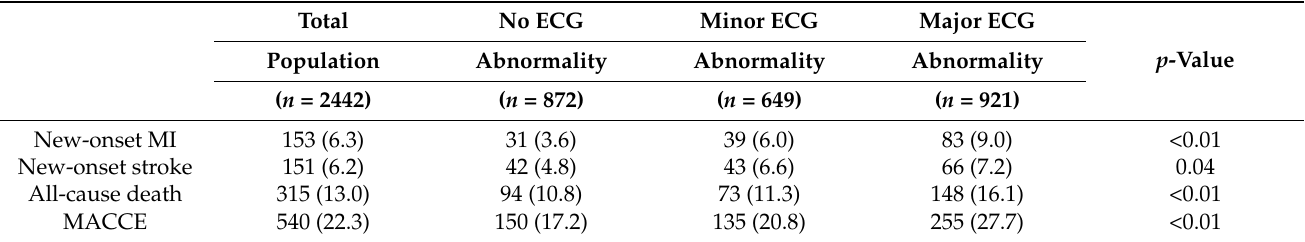
Table 3. The cumulative incidence rates of new-onset MI, stroke, death, and